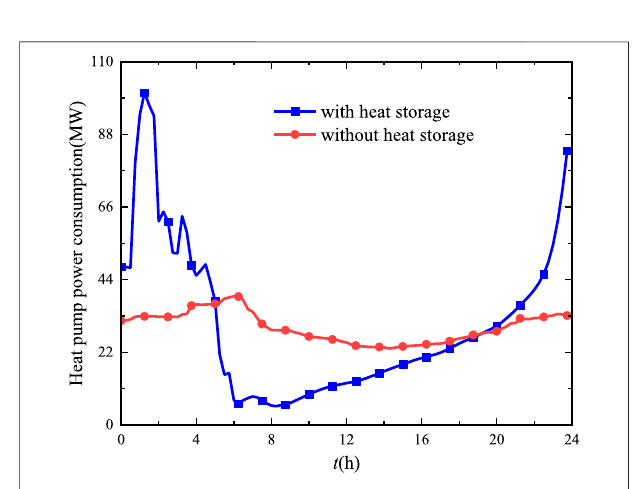
FIGURE 9 | Power consumption curve of the electric heat pump in a typical